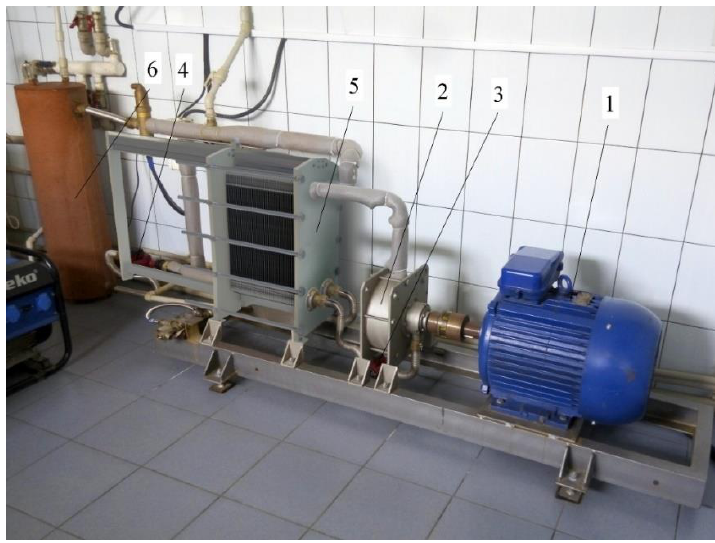
Figure 3. Experimental stand to test the operating efficiency of the disk pulse heat generator: 1–electric engine; 2–chamber of the disk pulse heat generator; 3, 4–pumps; 5–plate-type heat exchanger; 6–accumulating tank.